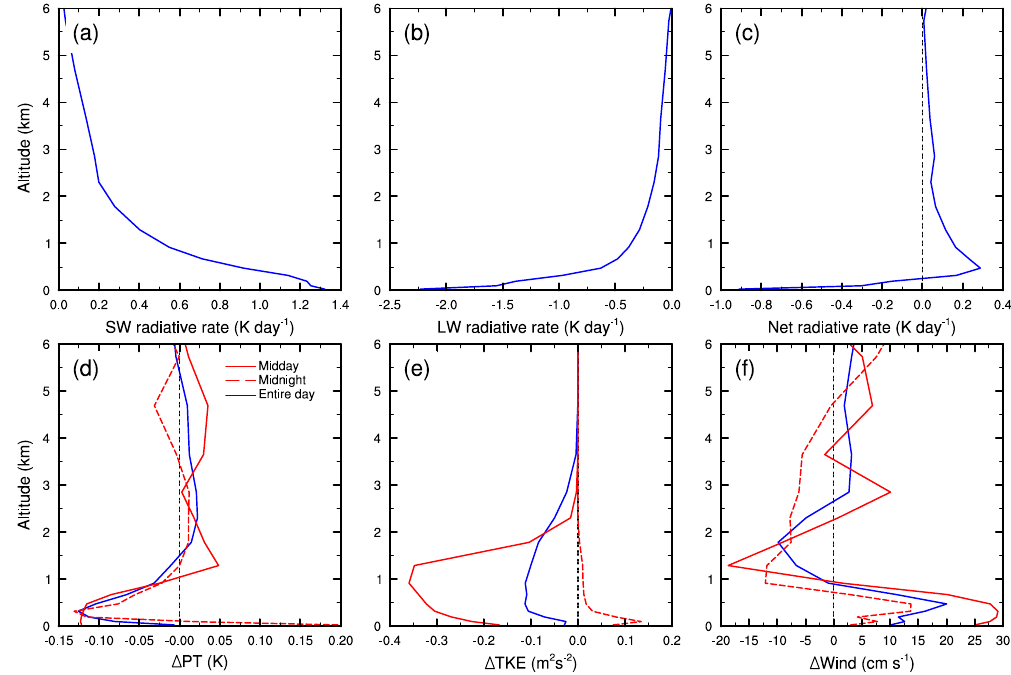
Fig. 1. Simulated atmospheric heating and cooling profiles (Kday − 1 ) due to the interaction of (a) shortwave, (b) longwave and (c) net radiation with dust aerosols, as well as (d) potential temperature (K), (e) turbulent kinetic energy (m 2 s − 2 ) and (f) wind speed (cms − 1 ) responses to direct radiative forcing by mineral dust averaged for July 2009 over Zabol (31.05 ◦ N, 61.47 ◦ E). Daytime and nighttime profiles correspond to monthly averaged values at 12:00 (midday) and 00:00 (midnight) local